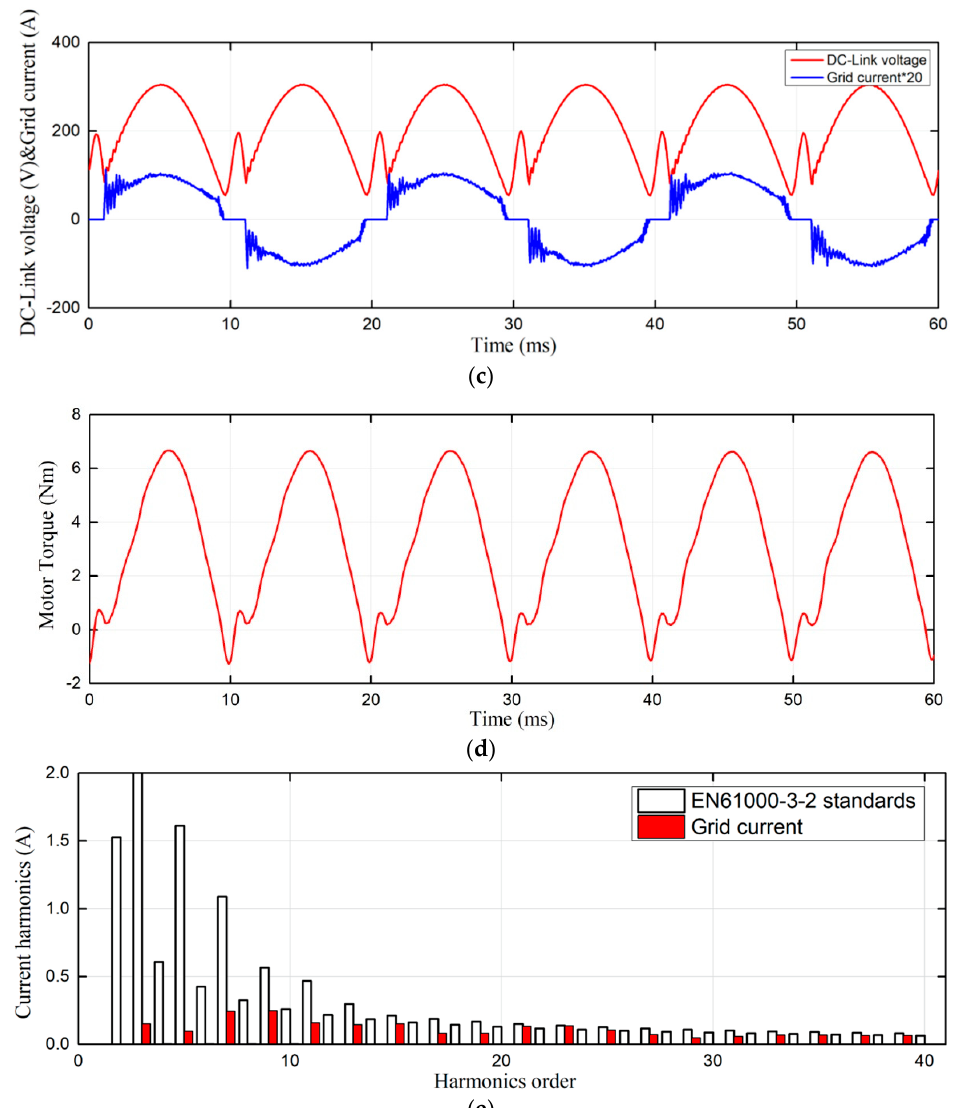
Figure 17. Simulation of conventional SMO only with a PIR controller: ( a ) Motor Speed; ( b ) Position and estimated error; ( c ) DC-link voltage and grid current; ( d ) Motor output torque; ( e ) FFT analysis of grid current.